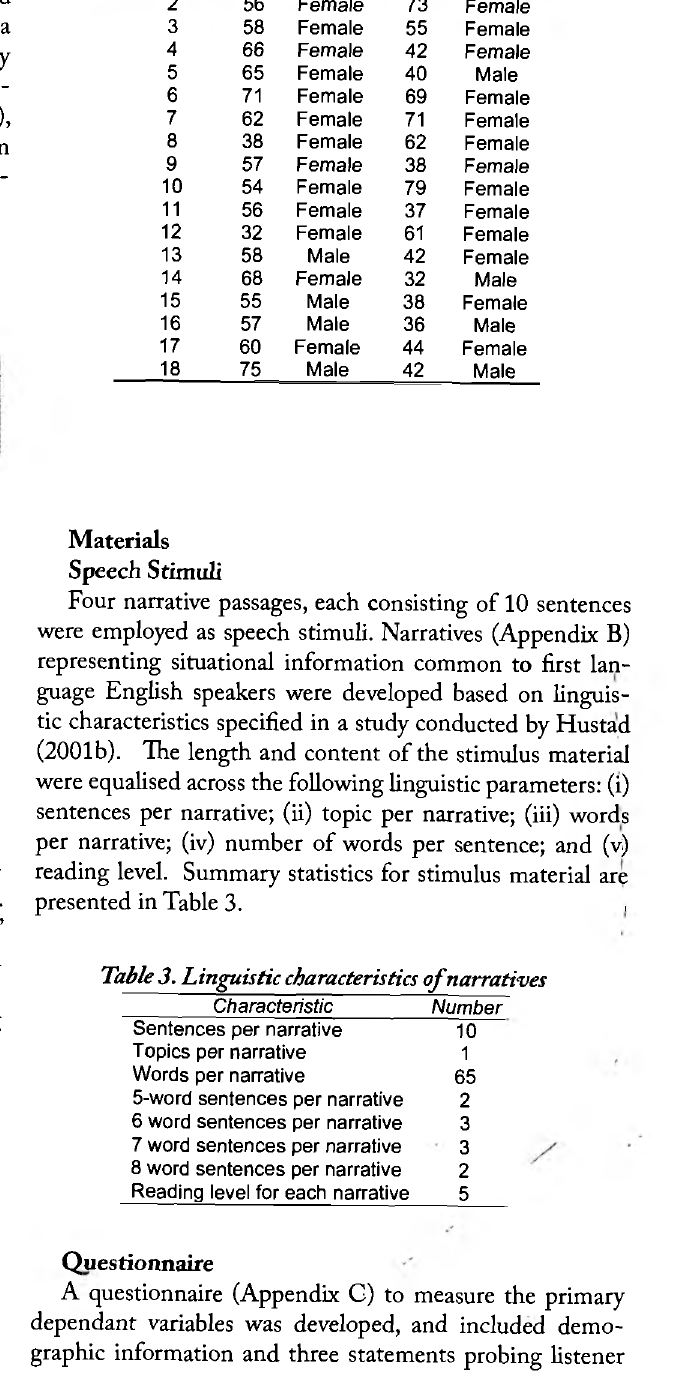
Table 2. Demographic inform ationfor the listener groups